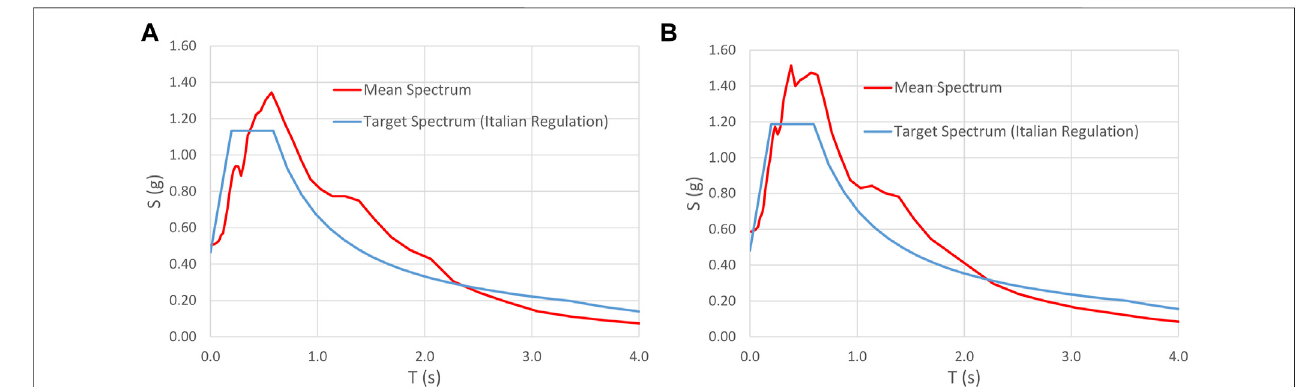
FIGURE 7 | (A) Response spectra for T r (cid:1) 949 years. (B) Response spectra for T r (cid:1) 2,475 years.